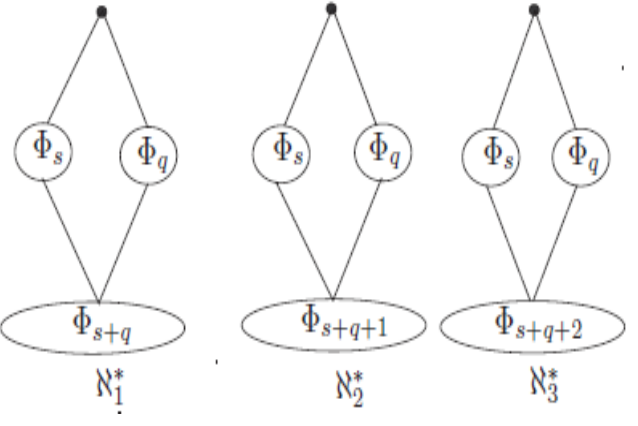
Figure 6. Graphs ℵ ∗